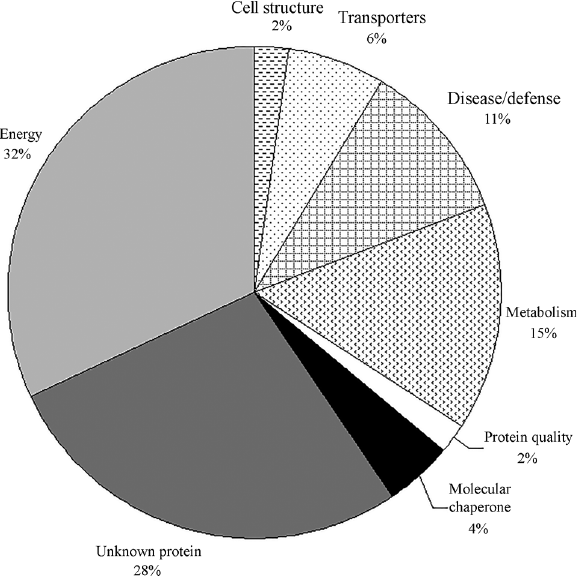
Figure 3 - Functional classifications of the identified proteins (Bevan et al. ,